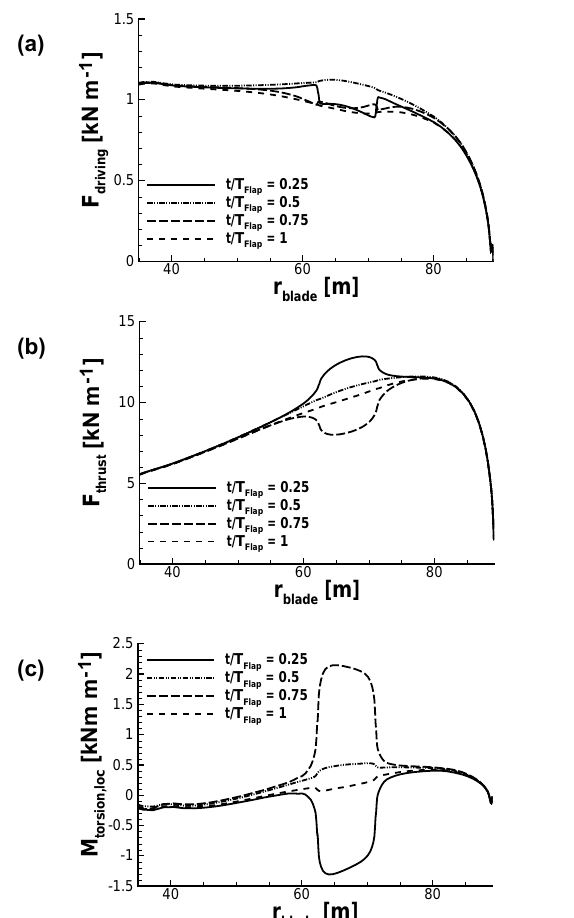
Figure 12. 1p sectional forces (driving force, a ; thrust, b ; and local torsion moment, c ).